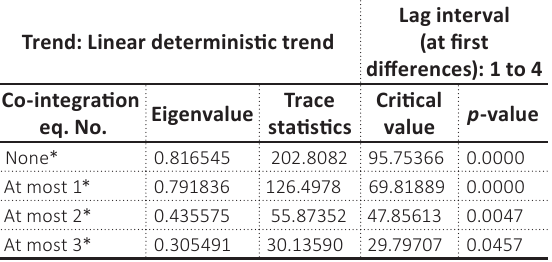
Table 4. The results of the co-integration rank